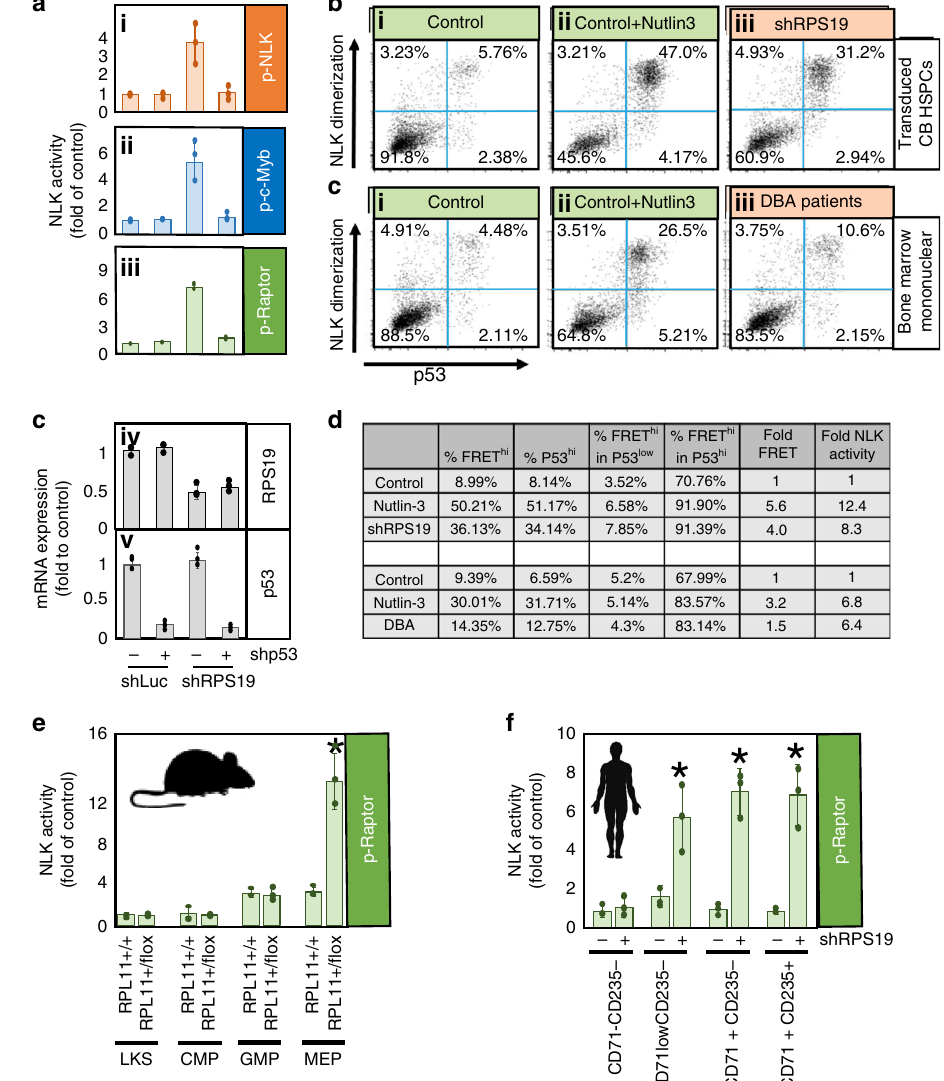
Fig. 6 NLK is activated in early erythroid progenitors and requires P53 stabilization in RPS19-insuf fi ciency. a Cord blood CD34 + progenitors were transduced with lentivirus expressing shRNA against luciferase (shLuc) or RPS19 (shRPS19) co-expressing GFP. Cells were also transduced with or without shRNA against p53 co-expressing mCherry. After 36 h, GFP + and GFP + ,mCherry + cells were differentiated in erythroid media for 8 days, followed by NLK kinase assay (i — NLK: orange, ii — Myb: blue, iii — Raptor: green) and qRT-PCR analysis of RPS19 (iv) and p53 (v) expression. b CD34 + cord blood HSPCs were transduced with control shRNA (shLuc) along with YFP- and CFP-tagged NLK and allowed to differentiate for 3 days, in the presence (i) or absence (ii) of Nutlin-3. Cells were stained for p53 and both p53 and FRET was measured by fl ow cytometry. For comparison, HSPCs were transduced with shRNA against RPS19 (iii). c Bone marrow mononuclear cells from healthy donors were transduced with YFP- and CFP-NLK and incubated alone (i), or with Nutlin- 3 (ii) for 24 h, prior to p53 and FRET analysis. Bone marrow mononuclear cells from three DBA patients were pooled and analyzed simultaneously (iii). d Documentation of the percentage of cells with dimerizing NLK in p53 hi and p53 low is tabulated and can be compared with NLK in vitro kinase activity. e — green Samples were gated to include non-erythroid CD71 - CD235 - populations, MEP- and BFU-E-enriched CD71 low CD235 - populations, CFU-E- enriched CD71 hi CD235 - populations and proerythroblast and intermediate erythroblast CD71 hi CD235 + populations. Sorted populations were lysed and immunoprecipitated NLK was subjected to in vitro kinase assay examining Raptor phosphorylation as a substrate. Activity was normalized to the non- erythroid control samples. f — green Sorted populations were lysed and immunoprecipitated NLK was subjected to in vitro kinase assay examining Raptor phosphorylation as a substrate. Activity was normalized to the Lin - Kit + Sca + RPL11 + / + samples. Bars represent means± SD with individual data points overlaid. n = 3 independent experiments performed in triplicate. Statistics: two-tailed Student ’ s t test, signi fi cant * p < 0.05.Also see Supplementary Fig. 7. Source data are provided as a Source Data fi lysosomal membrane 16 . Strong co-localization (depicted in silenced (Fig. 7b), indicating NLK-dependent phosphorylation yellow) of Raptor (red) with the lysosome (green) was observed and mis-localization of Raptor in RPS19-insuf fi ciency. by fl uorescence confocal microscopy in CD71 + CD235 − differ- NLK-dependent phosphorylation of c-Myb in breast cancer entiating progenitors in control cells (shLuc) expressing non- and Wnt signaling has been demonstrated to facilitate rapid targeting or siRNA against NLK (Fig. 7b). Co-localization was ubiquitination and subsequent proteasome degradation 4,14,15,24 . Reduced c-Myb expression has been reported in DBA 5,63 and is disrupted in RPS19-insuf fi ciency but restored when NLK was